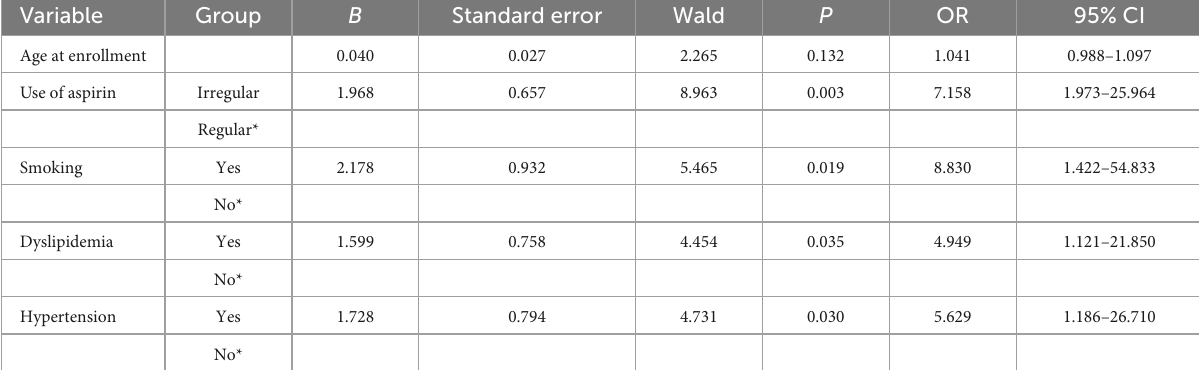
TABLE 4 Multivariate logistic regression analysis of the influencing factors of AR.